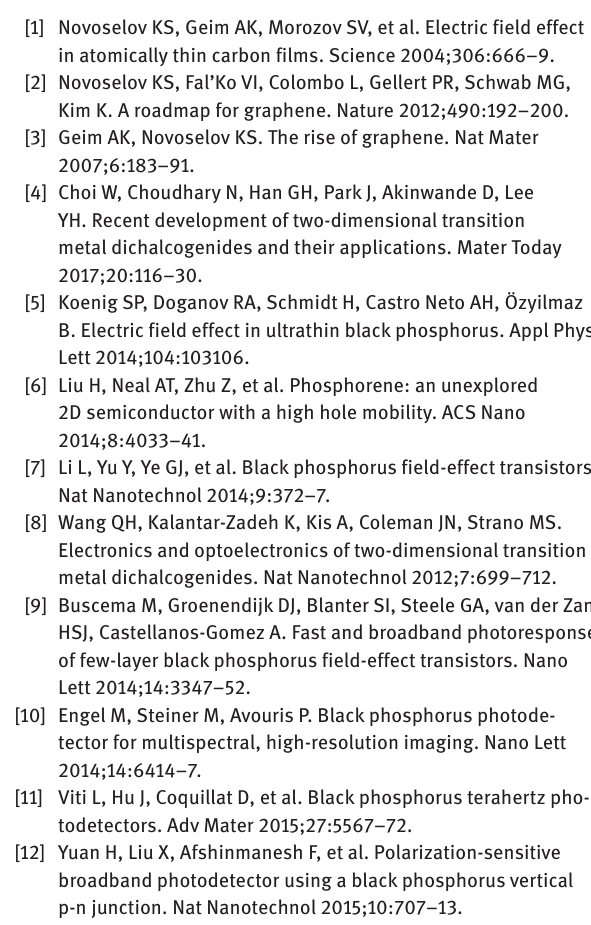
Figure 7: Comparison of calculated α Comparison of (A) Hooge parameter ( α FETs on different substrates calculated according to the Hooge noise model and the McWorther model,